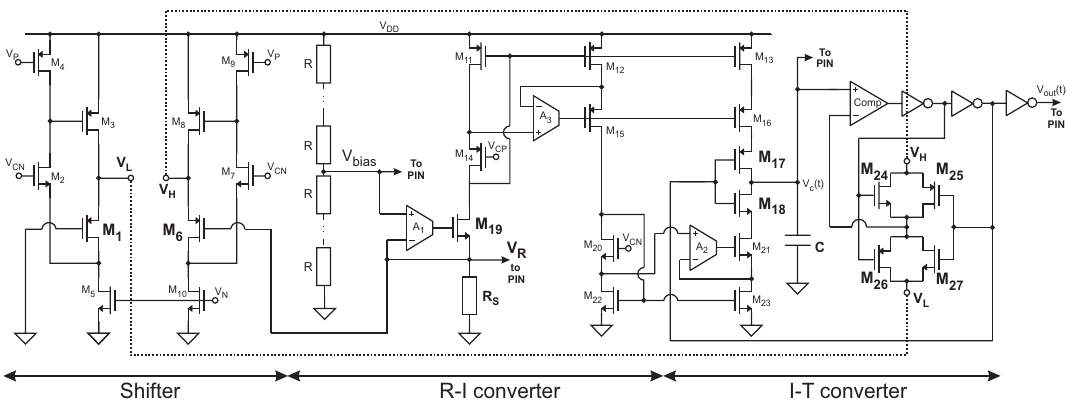
Figure 3. Implementation at transistor level of the proposed approach.